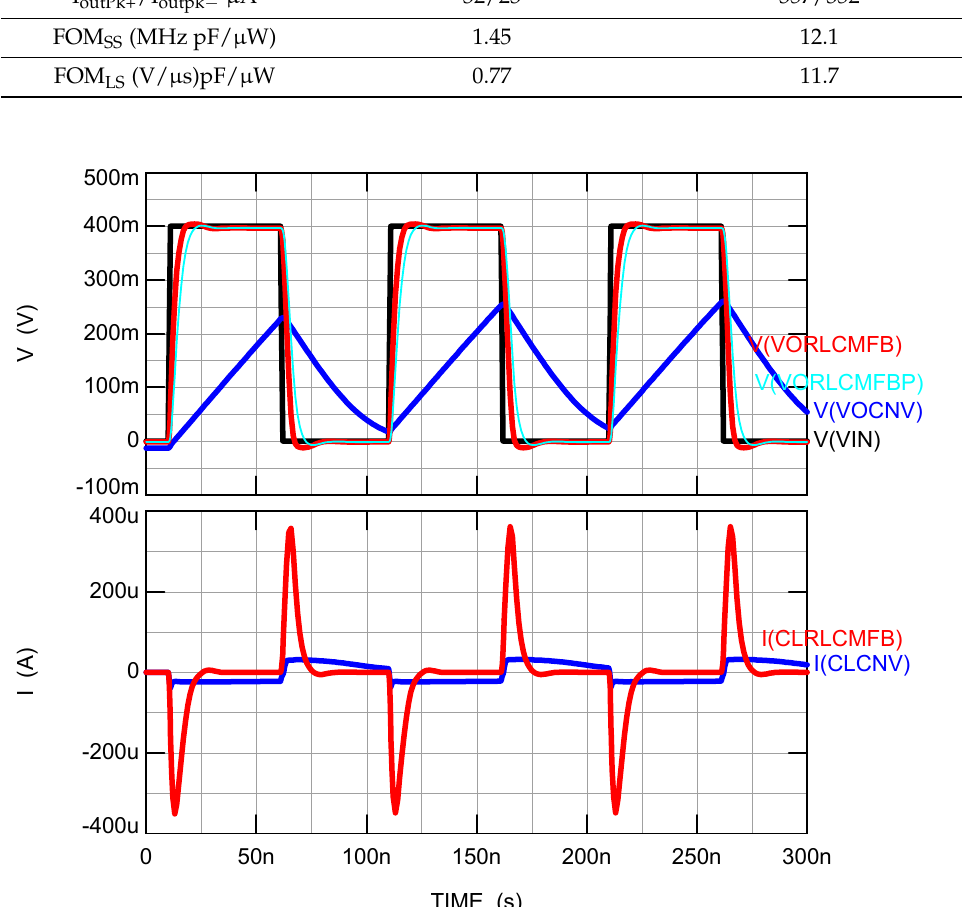
Figure 6. Transient response of circuits of Figure 3. Top: input and output voltages, bottom: output currents.